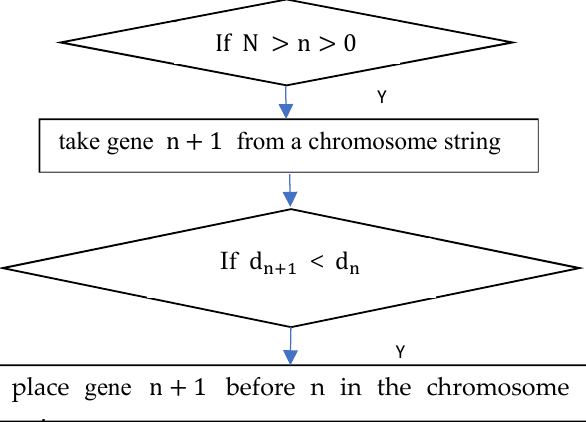
Figure 5. Block diagram of the EDD procedure.